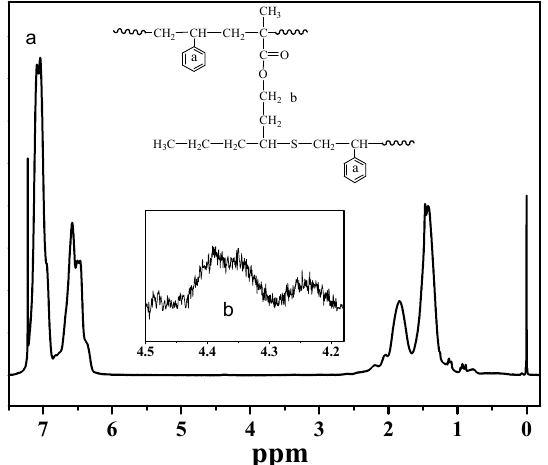
Figure 2. 1 H-NMR spectrum of the polystyrene St 100 -MHM 2.0 -AIBN 3.0 . AIBN: 2,2 ′ -Azobisisobutyronitrile; MHM: 3-mercapto hexyl methacrylate; St: Styrene.